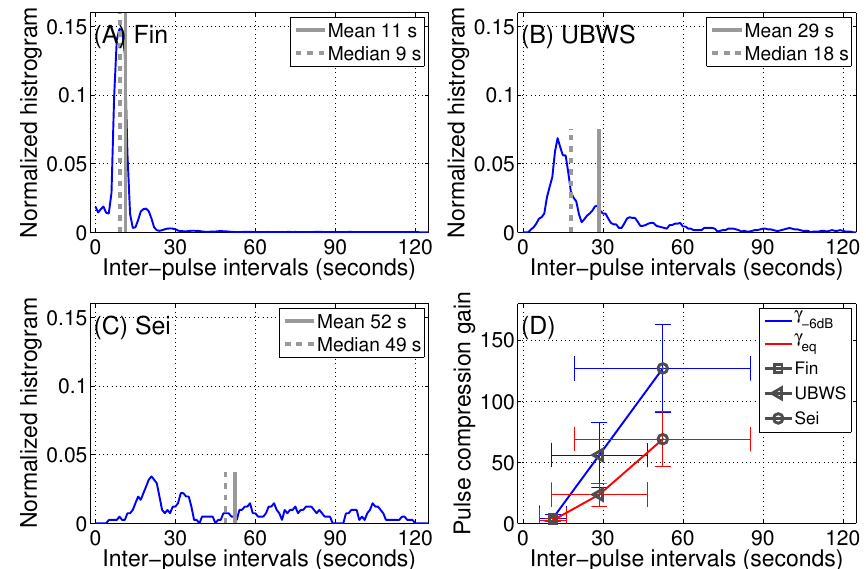
Figure 9. Distribution of Inter-Pulse Intervals (IPIs) for ( A ) fin whale 20-Hz pulses; ( B ) unidentified baleen whale species downsweep calls; and ( C ) sei whale downsweep chirps. For sei whales, the IPIs of their vocalizations in a doublet or triplet are not included. All IPIs larger than two minutes are excluded from the analysis; ( D ) The pulse compression gains, γ − 6 dB and γ eq , are plotted as a function of the IPIs. The IPI distributions are characterized by the following means and standard deviations, in units of seconds: 11 ± 5 for fin whale, 29 ± 18 for unidentified baleen whale species and 52 ± 33 for sei